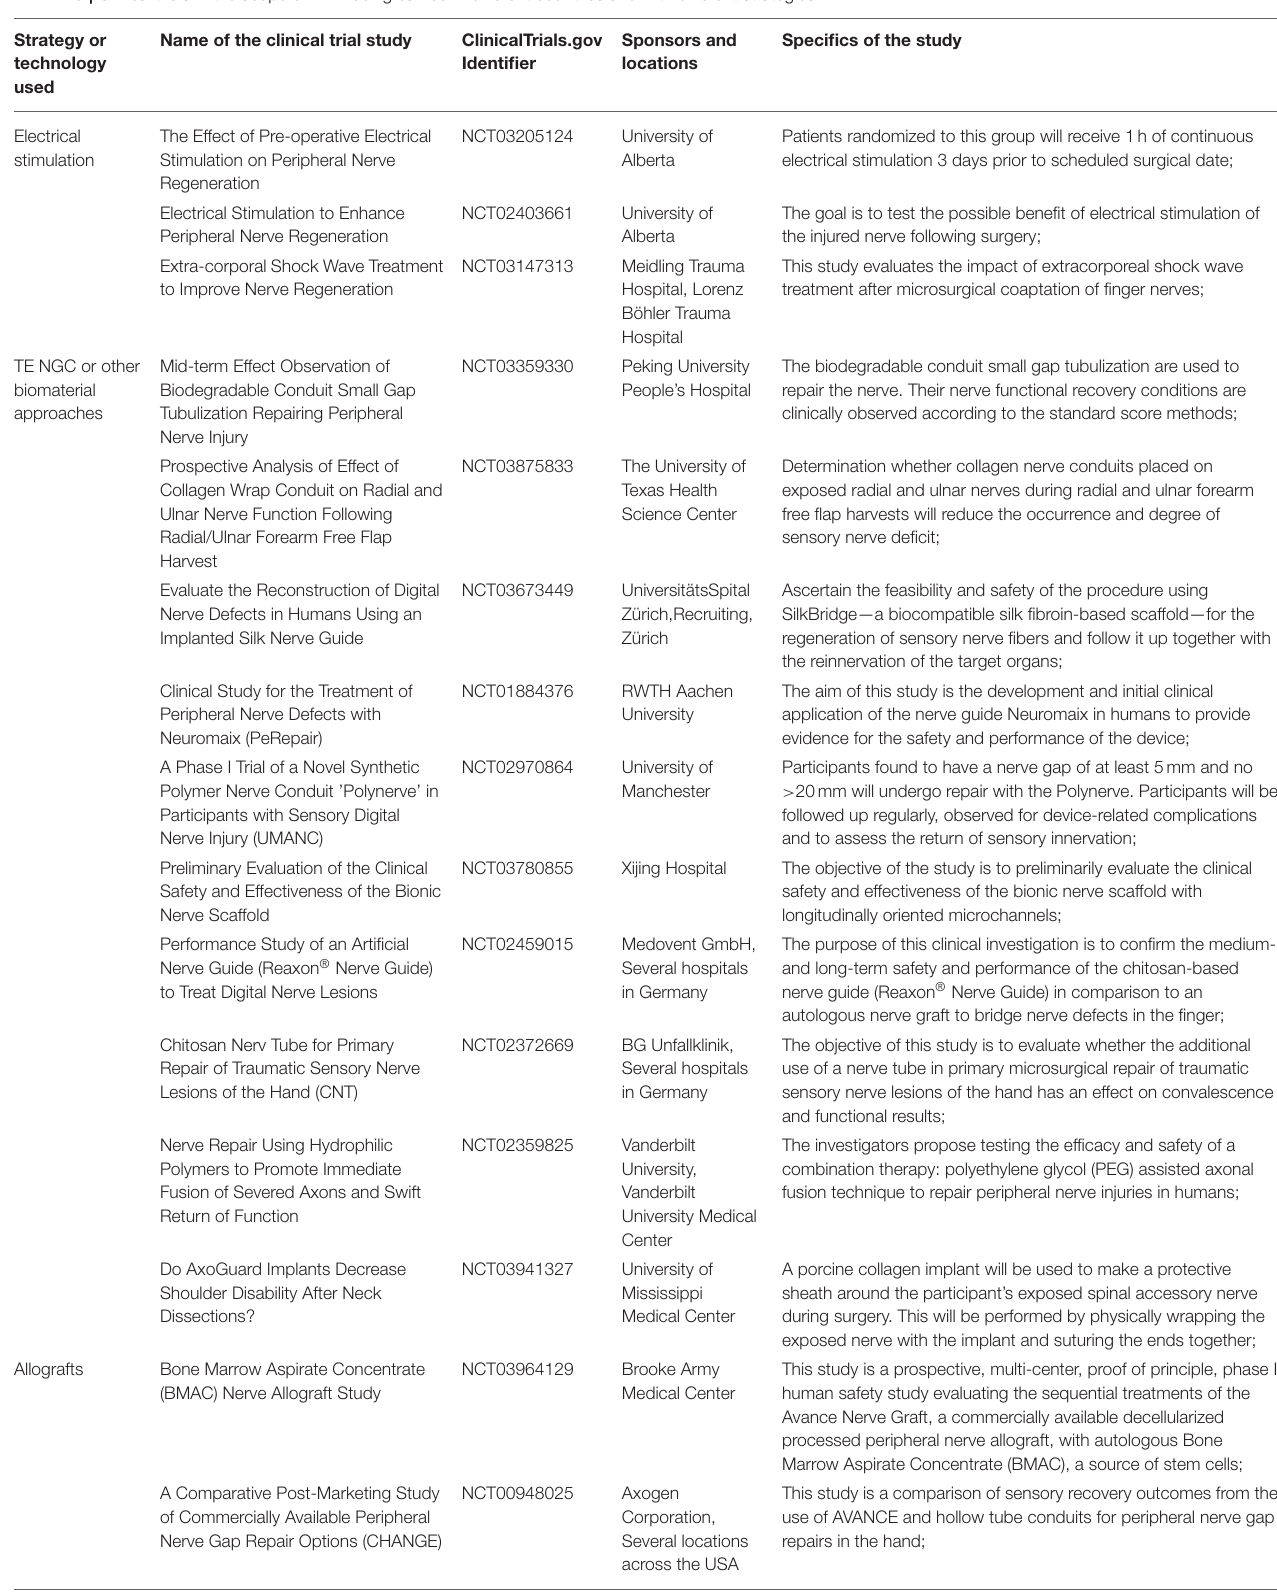
TABLE 3 | Clinical trials in the scope of PNR being carried in different countries and with different strategies. Strategy or